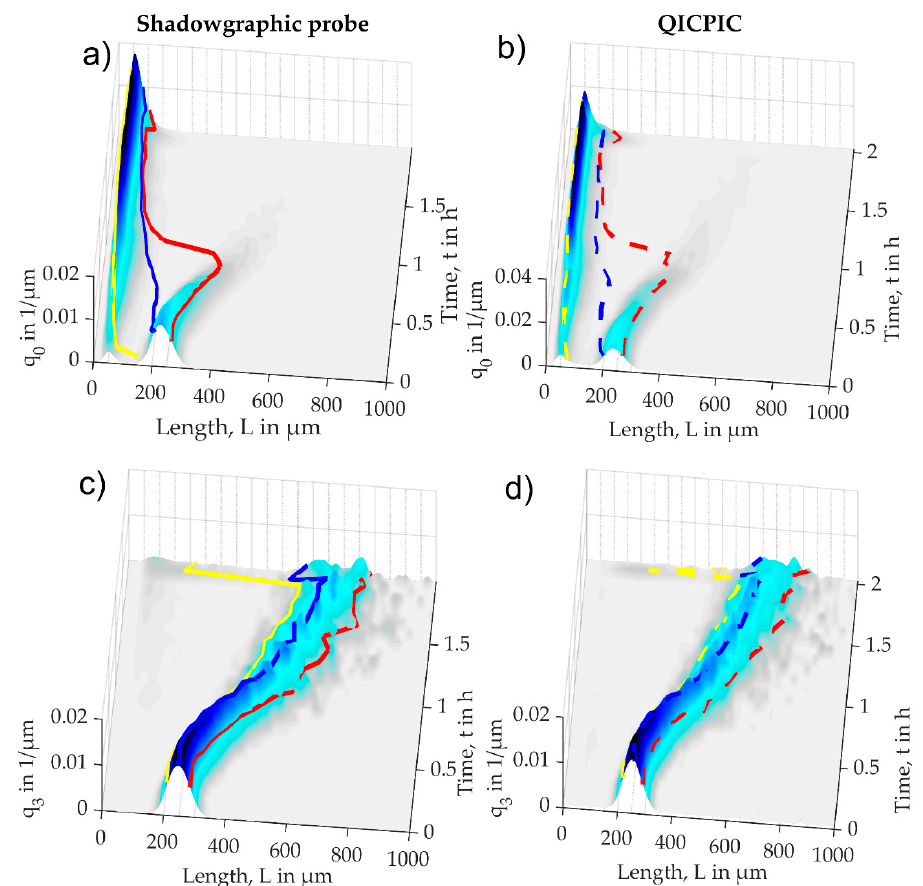
Figure A6. Exp. 2—KH 2 PO 4 distributions ( a ) q 0 -distribution shadowgraphic probe; ( b ) q 0 -distribution QICPIC; ( c ) q 3 -distribution shadowgraphic probe; ( d ) q 3 -distribution QICPIC. Solid lines —percentiles of the shadowgraphic probe; Dashed lines —percentiles of the QICPIC; yellow and red − 0.15 and 0.85 percentile distribution; blue —transient mean sizes of the distribution.